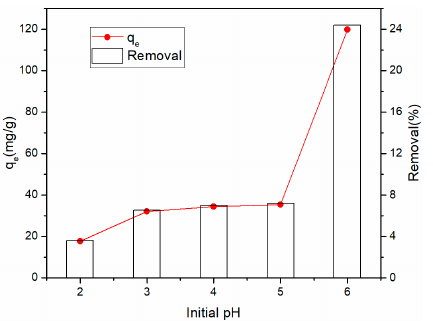
Figure 5. Effect of pH on the removal and adsorption of Cu 2+ .